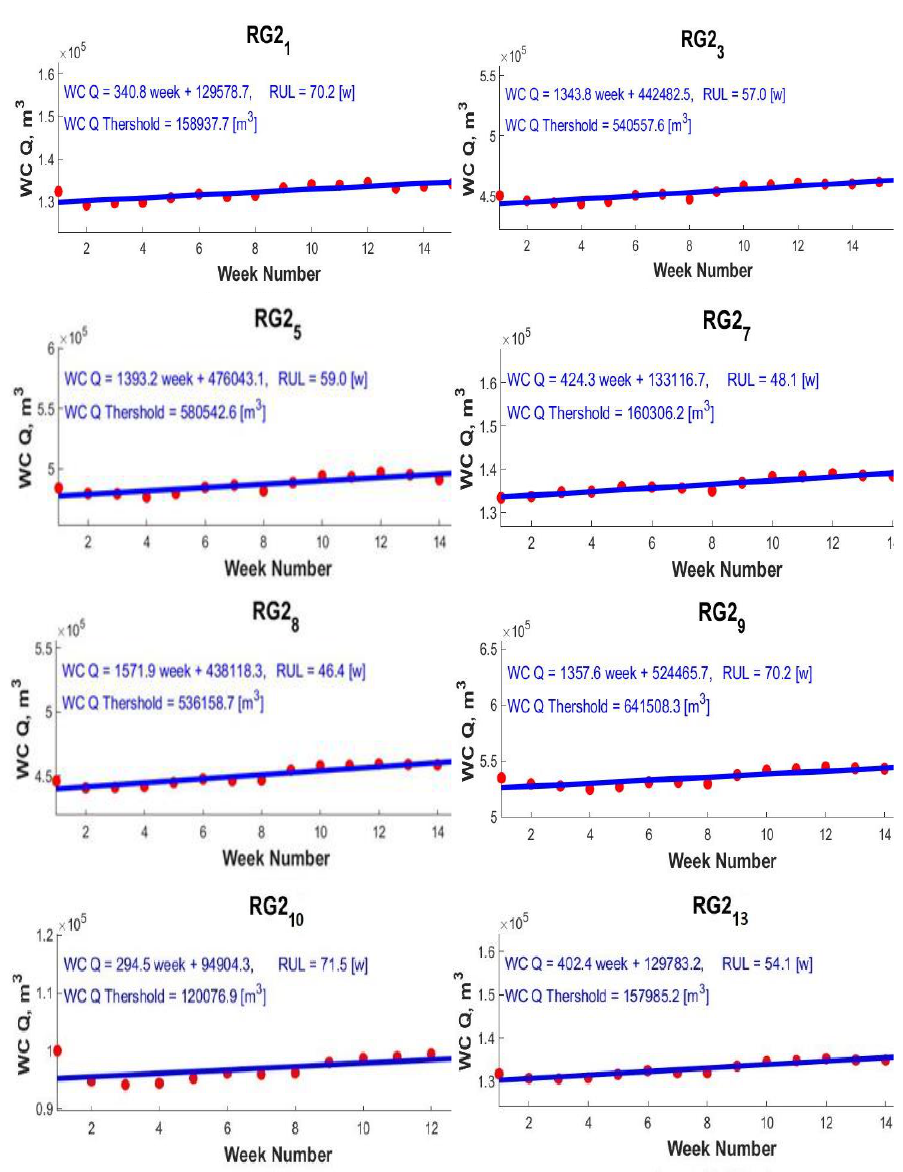
Figure 8. The weekly cumulative flow and filter RUL estimation for different PRs. The linear regression line is shown in each plot, along with the slope and intercept.